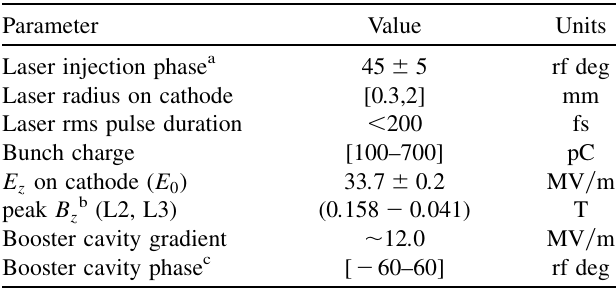
TABLE I. Nominal settings for the rf gun, booster cavity, and the photocathode UV laser.